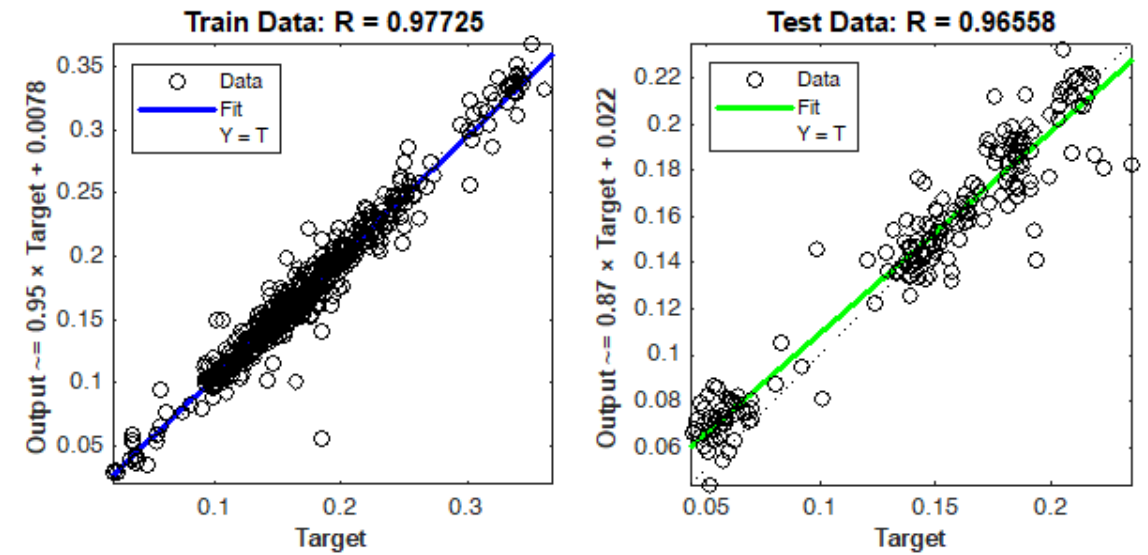
Figure 16. Regression coefficients for the training and testing phase, for ANFIS FCM model.